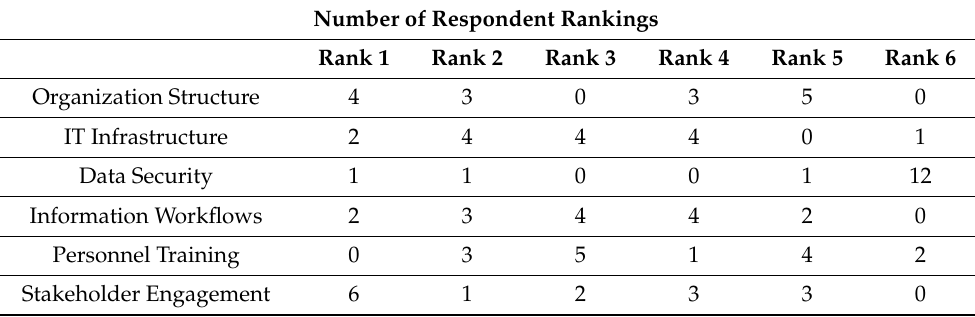
Table 5. Number of responses ranking the implementation